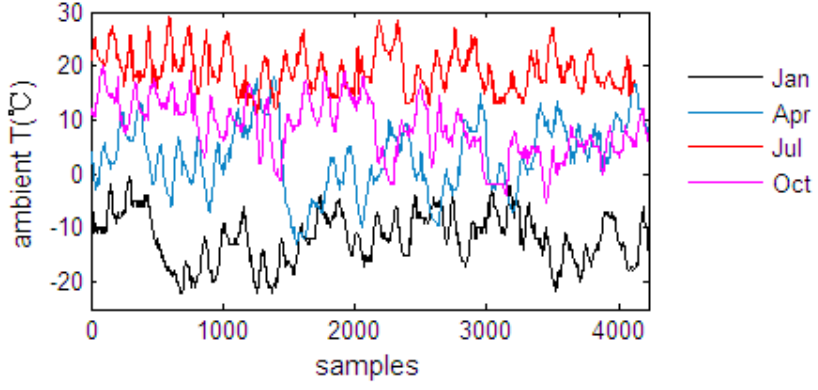
Figure 2. Ambient temperature in different seasons.